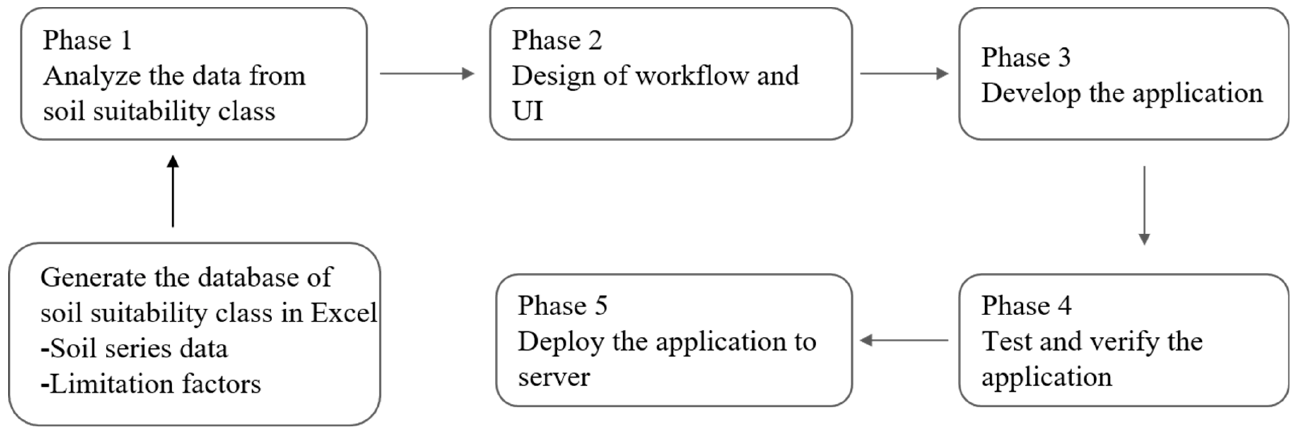
Figure 1. Development processes of mobile application for selecting mung bean cultivation areas.